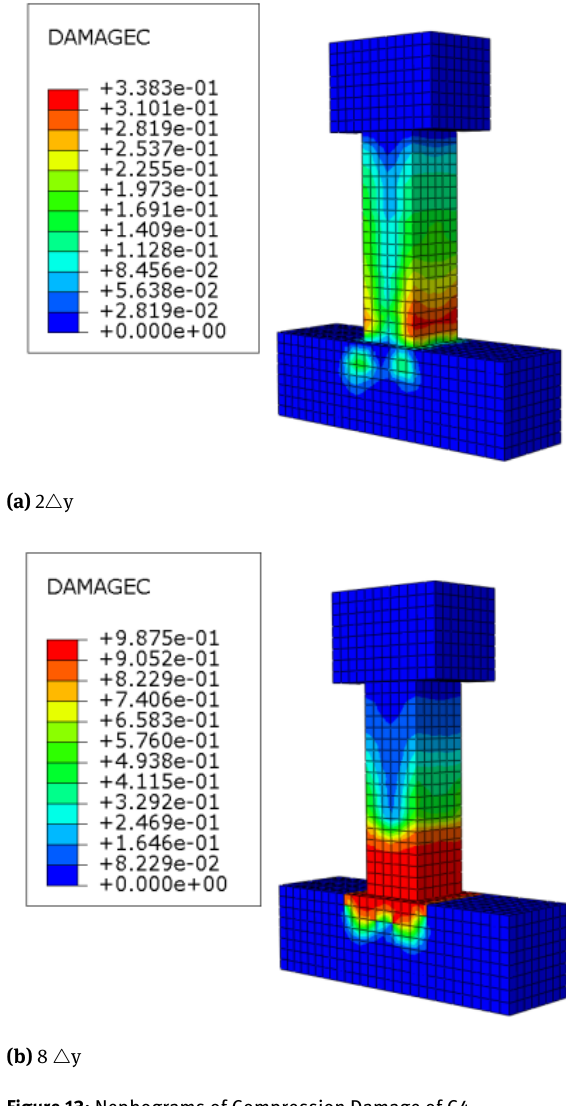
the carbon fibre strain increases gradually with